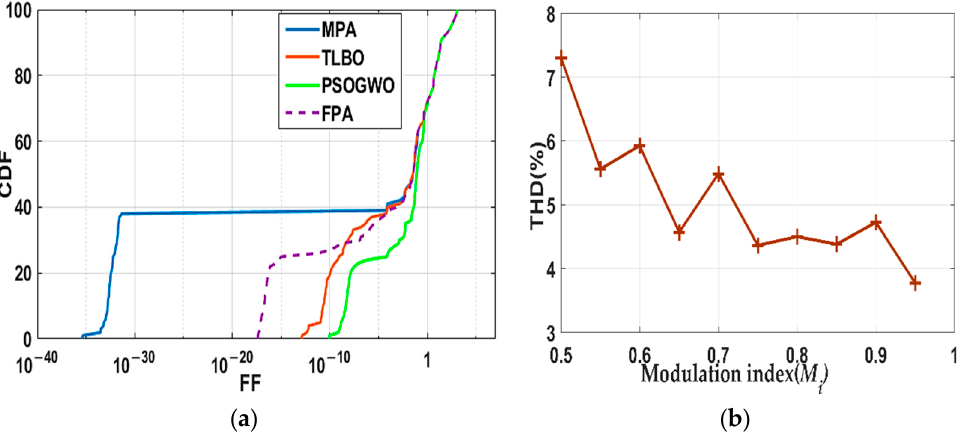
Figure 6. ( a ) Cumulative distribution function (CDF) versus fitness function (FF); ( b ) total harmonic distortion (THD) at different values of M i .